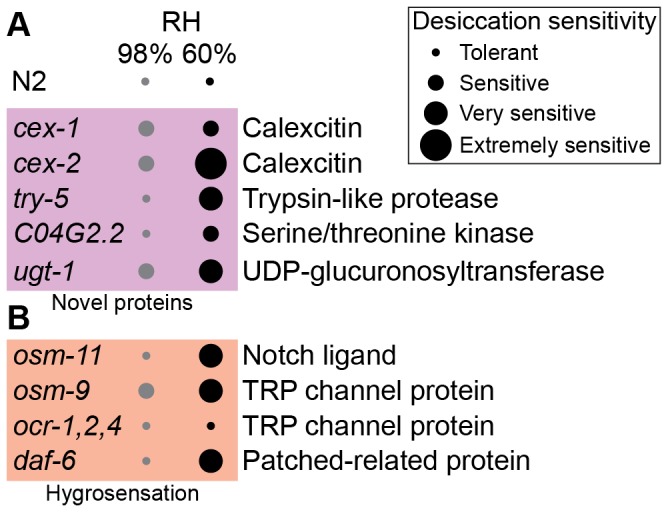
Novel DTR proteins and putative elements of the hygrosensation pathway involved in desiccation tolerance.